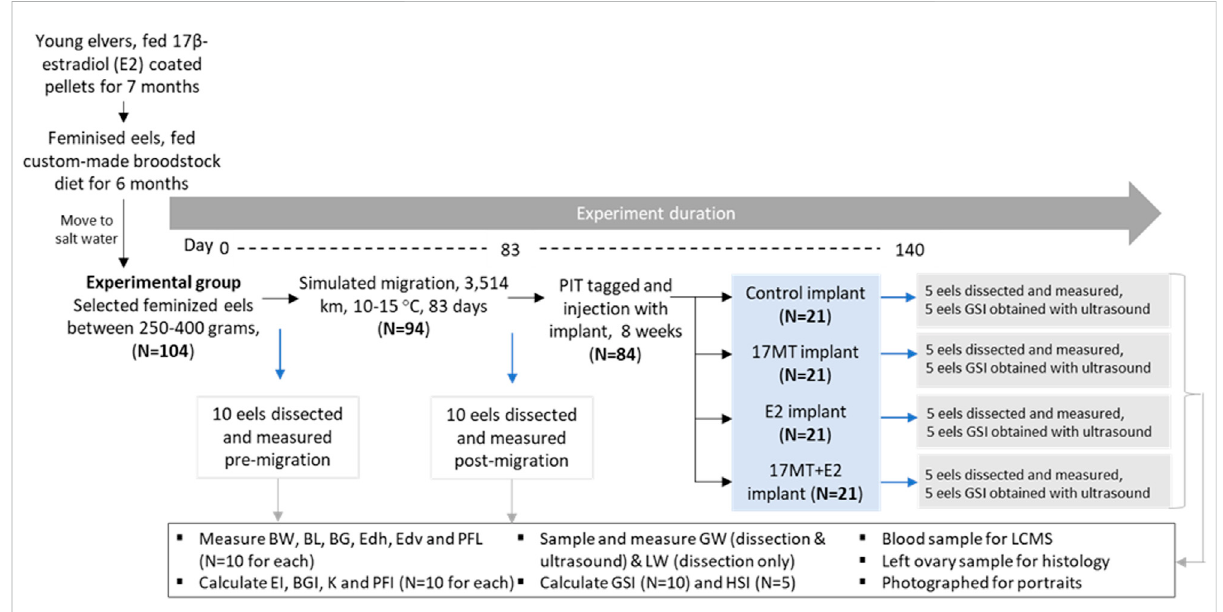
FIGURE 1 Experimental set-up. The 16 remaining eels per implant treatment group were matured by weekly injections with carp pituitary extract. Abbreviations:BW=bodyweight;BL=bodylength;BG=bodygirth;GW=gonadweight;LW=liverweight;EDh=Eyediameterhorizontal;EDv=eye diametervertical;PFL=pectoral fi nlength;K=Fulton ’ sconditionfactor;BGI=bodygirthindex;GSI=gonadosomaticindex;HSI=hepatosomaticindex; EI = eye index; PFI = pectoral fi n index; 17 MT = 17 α -methyltestosterone; E2 = 17 β -estradiol; LCMS = liquid chromatography mass